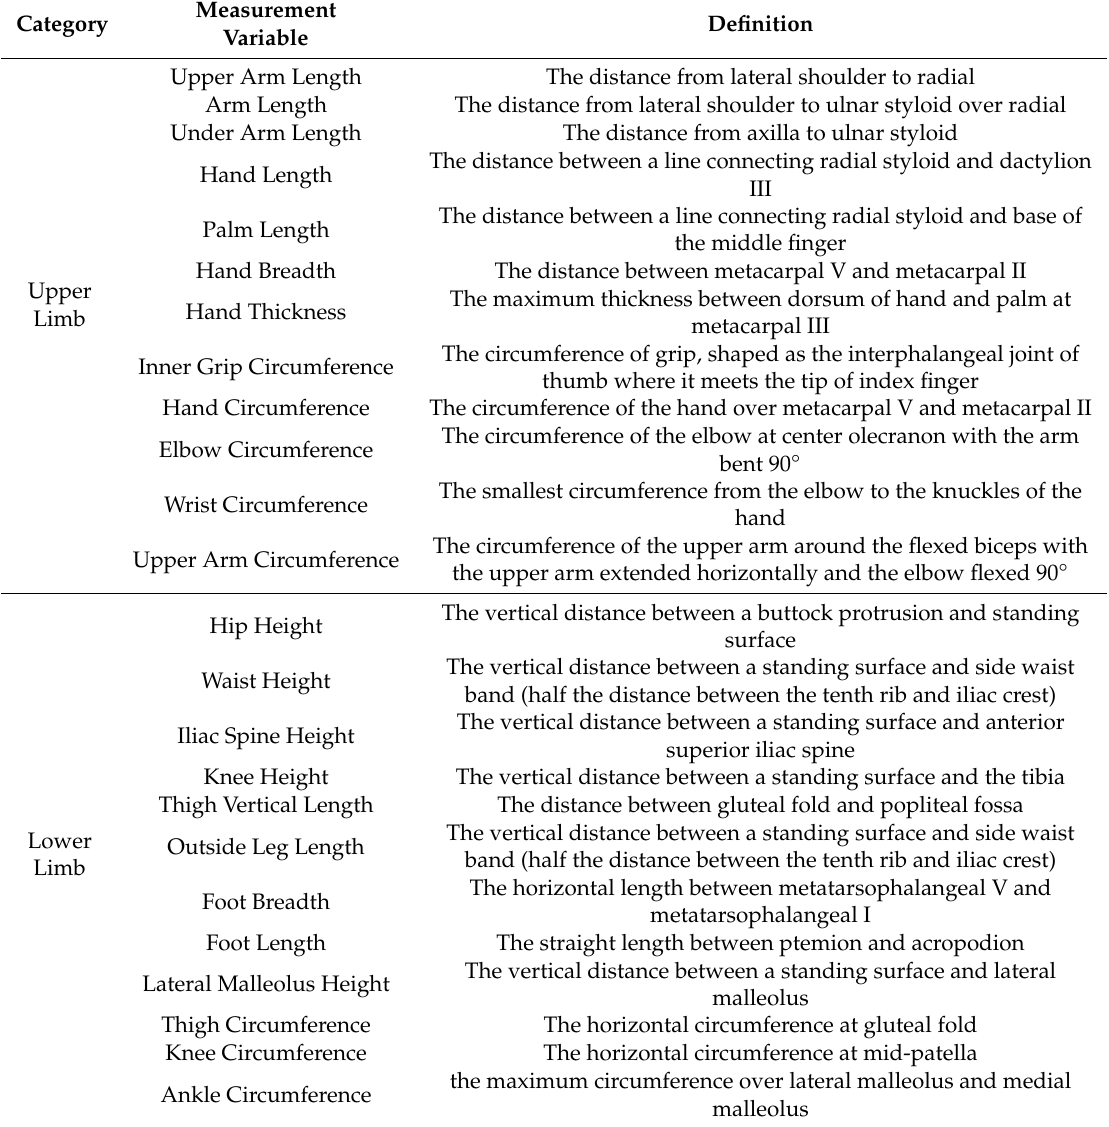
Table 1. Measurement variables used in the